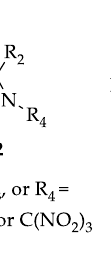
Figure 3. Structure of trinitromethane derivatives of diaziridine 12 ( A ) and 1-(trinitromethyl)dia- ziridine 13 ( B ). diaziridine 13 ( B